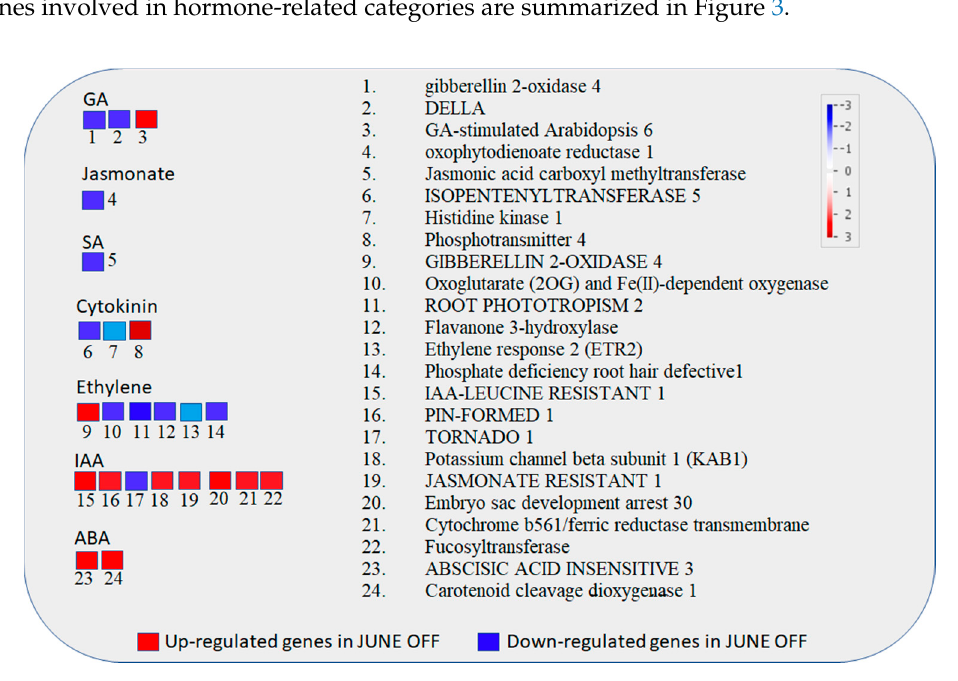
Figure 3. Figure shows hormone metabolism in Pistachio among the June “OFF” vs. June “ON” inflorescence bud comparison. The color scale indicates the log2 FC value. Red represents up-regulation and blue represents down-regulation in June “OFF” buds relative to June “ON” buds.